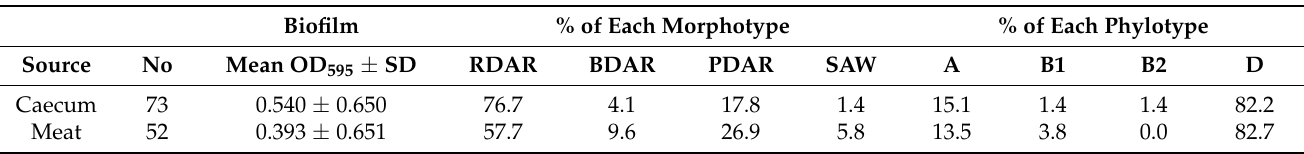
Table 5. Biofilm production by ESCR E. coli strains as indicated by OD 595 in the crystal violet biofilm assay, as well as distribution of morphotypes within each